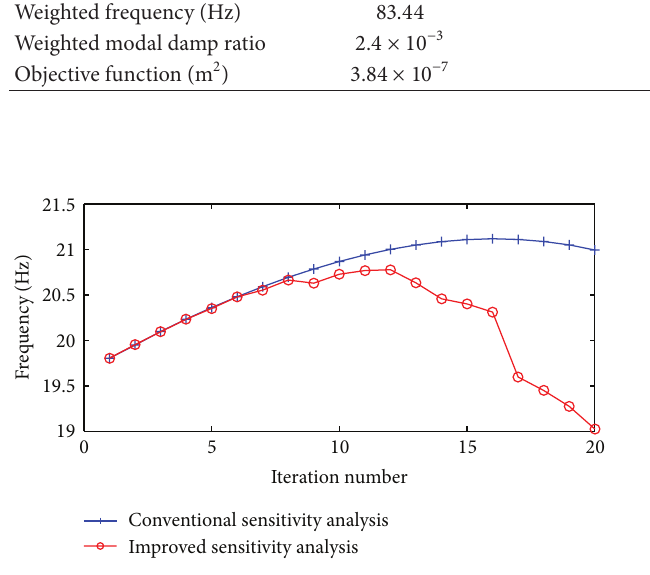
Figure 6: Iteration histories of the first-order frequency.